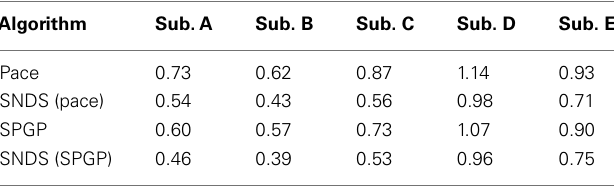
Table 2 | Comparison of decoding performance between pace regression, Gaussian process, and SNDS using the output of these two